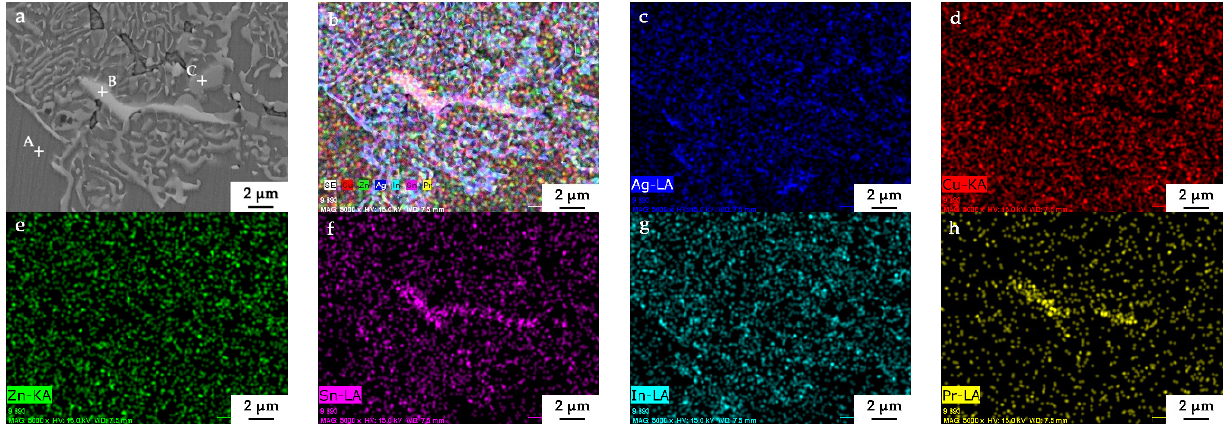
Table 4. EDS analysis results of the points indicated in Figure 8 (at.%).